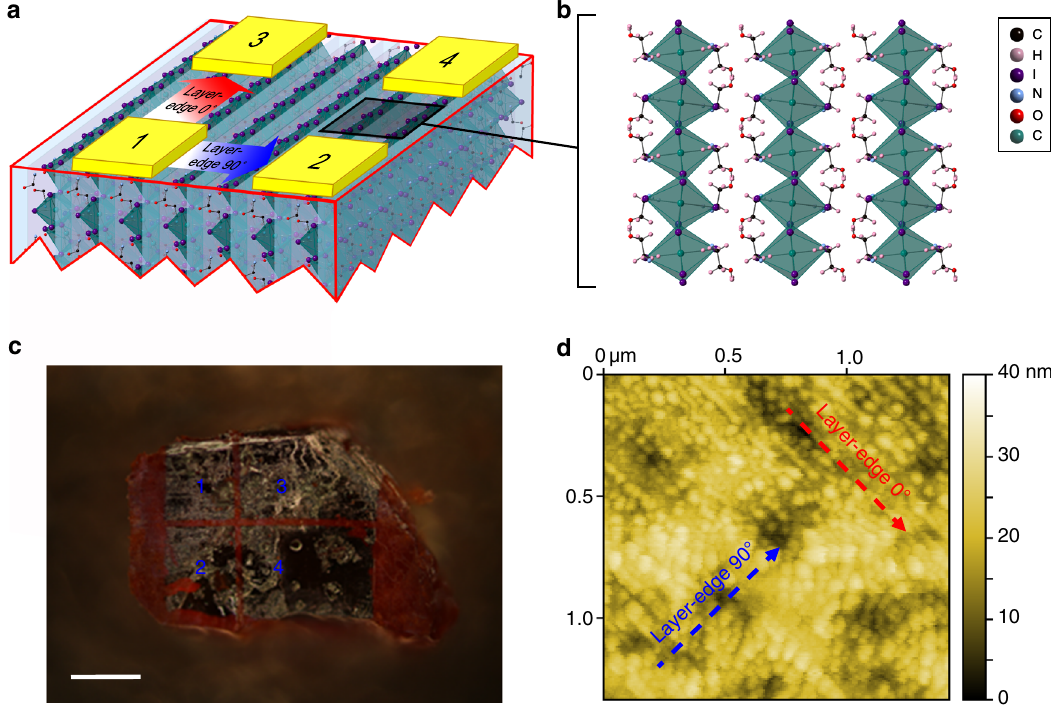
Fig. 1 Layer-edge device. a Schematic diagram of layer-edge surface of 2D perovskite (HOC 2 H 4 NH 3 ) 2 PbI 4 . Blue arrow and red arrow between electrodes indicate the direction of layer-edge 90° and 0°, respectively. b Top view of layer-edge surface. c Optical image of layer-edge surface device. The scale bar is 400 μ m. d AFM image of layer-edge surface